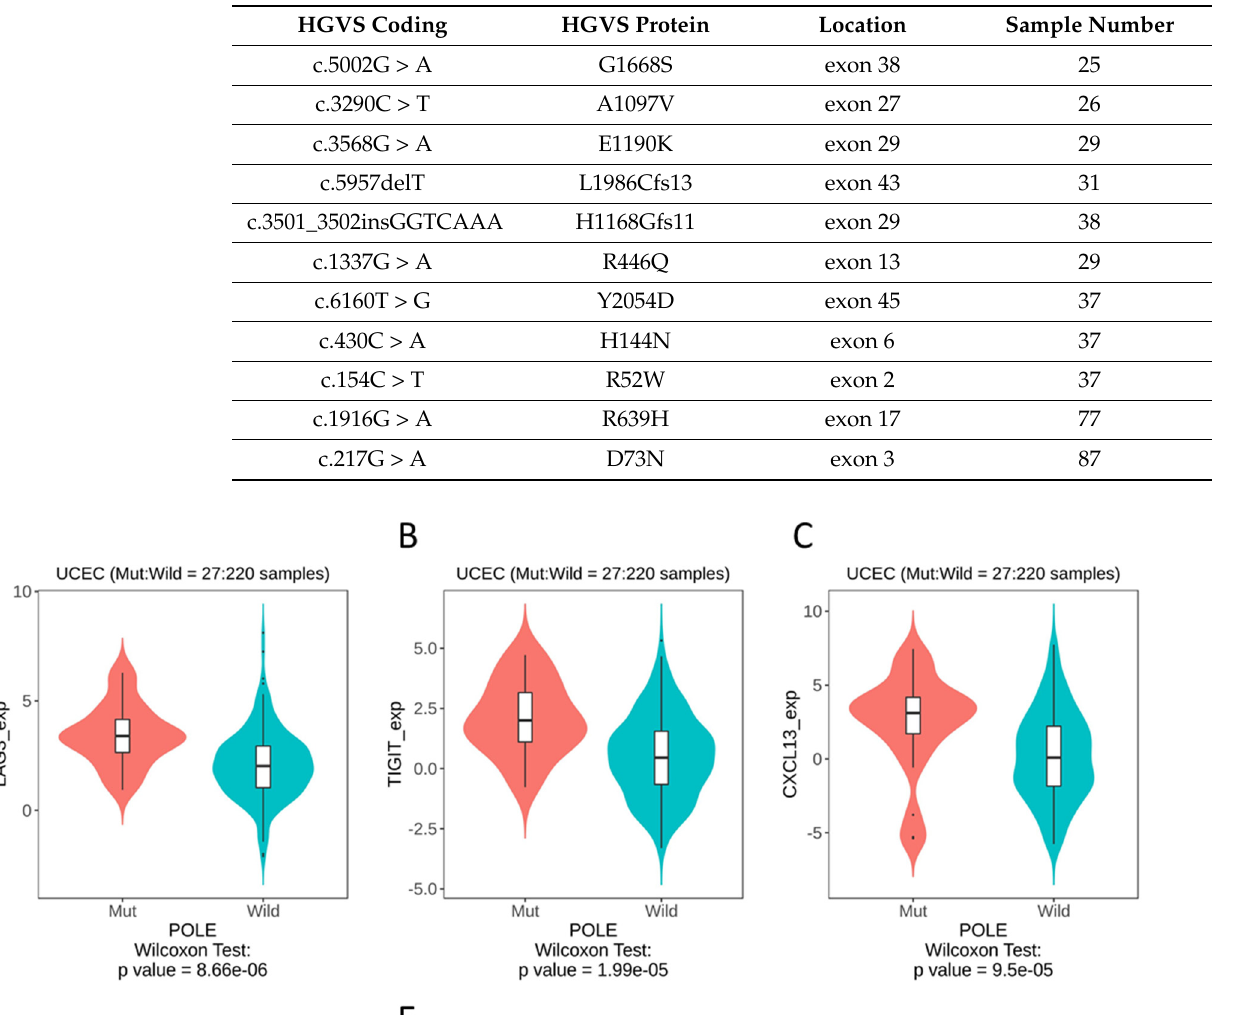
Table 5. Novel POLE mutations likely to be pathogenic.